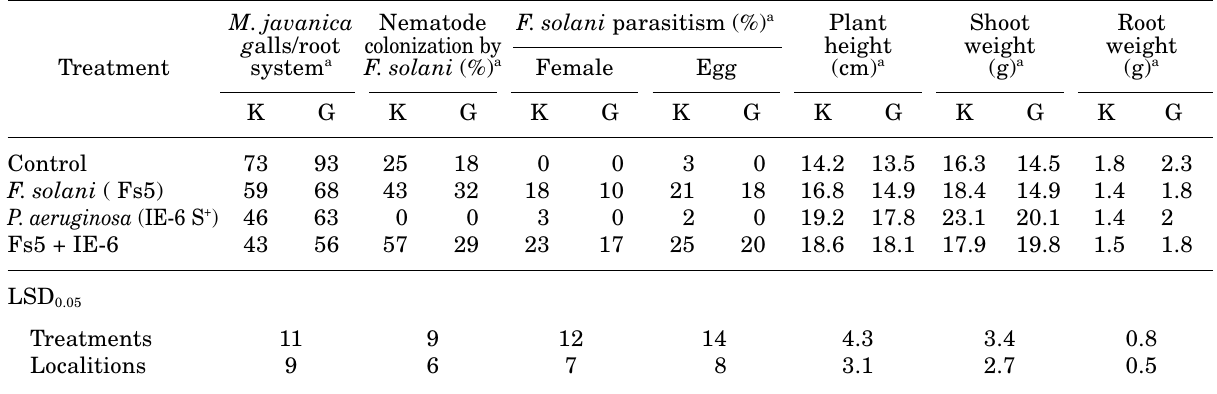
Table 5. Effect of Fusarium solani (strain Fs5) alone or in combination with Pseudomonas aeruginosa (strain IE- 6S + ) on the development of root-knot infection, nematode invasion, and root colonization by F. solani , and on female and egg parasitism by the fungus and growth of tomato plants under field conditions at Karachi (K) and Gharo